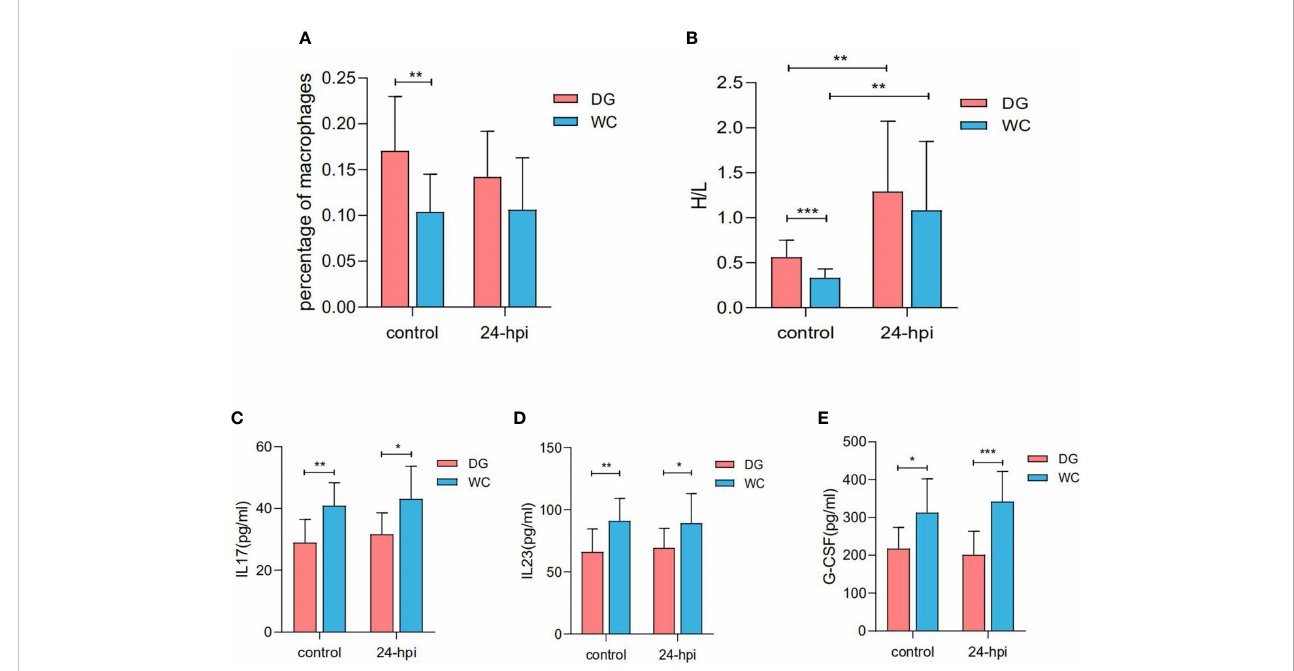
FIGURE 1 Immunological parameter differences between Dagu chickens and Wenchang chickens with or without Salmonella infection at 28 days old. (A) The percent of macrophages in peripheral blood differences between Dagu chickens and Wenchang chickens (n=12~13 per group); (B) Comparation of H/ Lratio in peripheral blood between Dagu chickens and Wenchang chickens (n=12~13 per group); (C) Concentration differences of IL17 in serum between Dagu chickens and Wenchang chickens (n=10~11 per group); (D) Concentration differences of IL23 in serum between Dagu chickens and Wenchang chickens (n=10~11 per group); (E) Concentration differences of G-CSF in serum between Dagu chickens and Wenchang chickens (n=10~11 per group). P < 0.05 (*), P < 0.01 (**) or P < 0.001